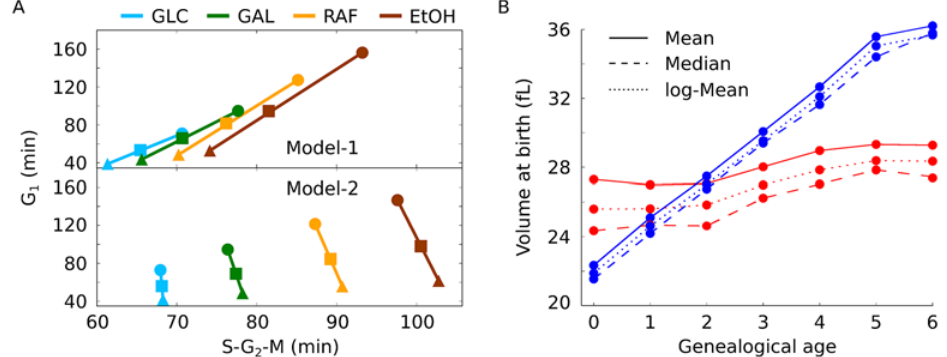
Fig 6. A bud sizer is required to equilibrate the budded phase of mothers and daughters and leads to larger daughters from older mothers. (A) G 1 and S-G 2 -M durations are displayed for populations simulated with Model-1 (top) and Model-2 (bottom) in glucose (GLC — light blue), galactose (GAL — green), raffinose (RAF — yellow) and ethanol (EtOH — brown). Durations are averaged for daughters (circles), mothers (triangles) or the entire population (squares). Lines show the difference between mothers and daughters. (B) The size of new-born cells is shown as a function of the replicative age of the mother for Model-1 (red) and Model-2 (blue). Shown are the mean of the culture, the median and the mean of log-transformed values.